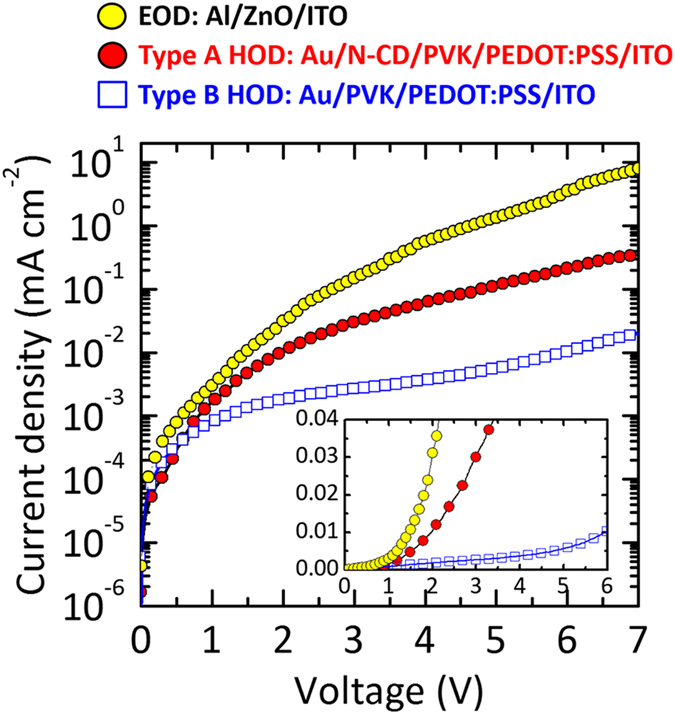
J–V characteristic curves of electron-only device (EOD) and hole-only devices (HOD) for the type A and type B QD-LEDs.The inset is the same curves plotted in a linear scale.